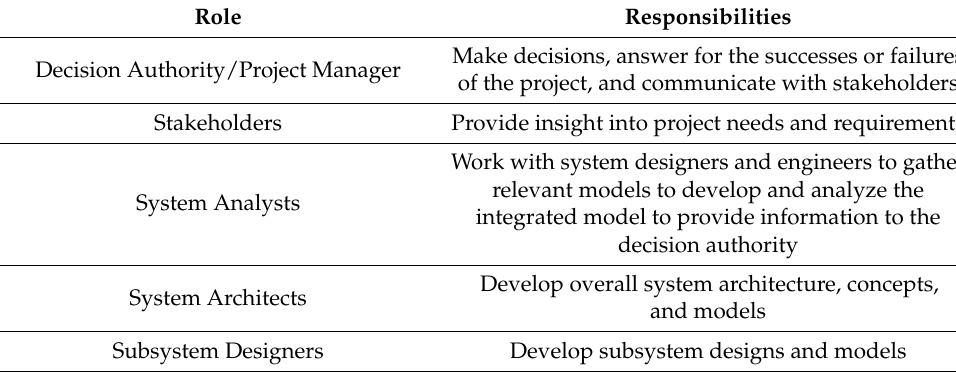
Figure 6. Quantitative Set-Based Design Process Swim Lane. Table 1. Roles and Responsibilities of Team-Based Set-Based Design Process.